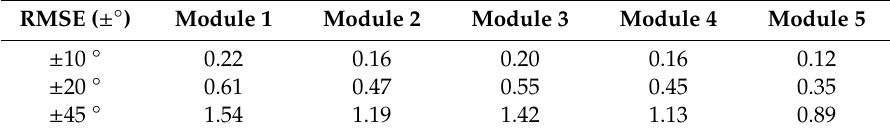
Table 1. RMSE values estimate for each module through precision inclined plane